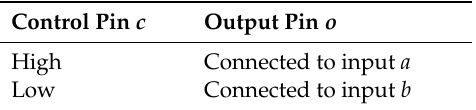
Table 2. Output table of analog switch.